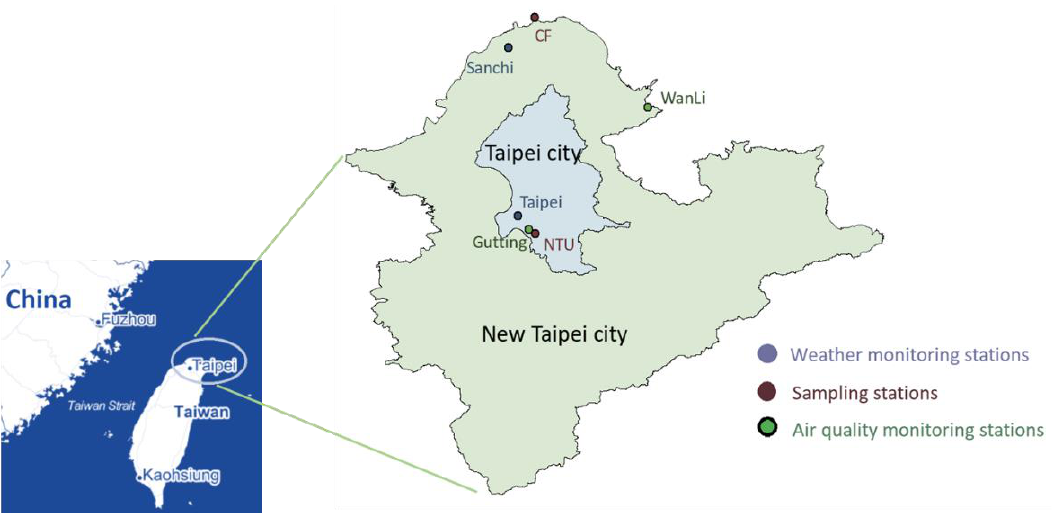
Figure 1. Distribution of sampling locations, weather monitoring stations, and air quality motioning Figure stations.